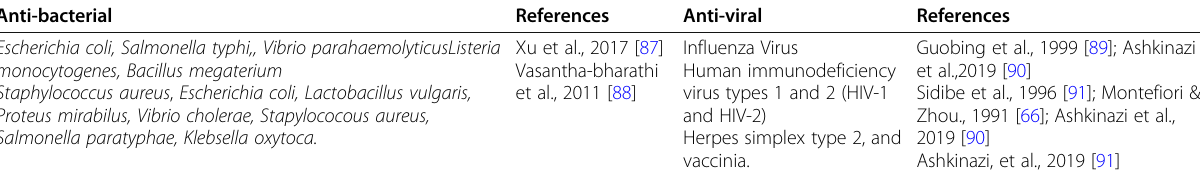
Table 3 Definite action of melanin against bacterial and viral pathogens